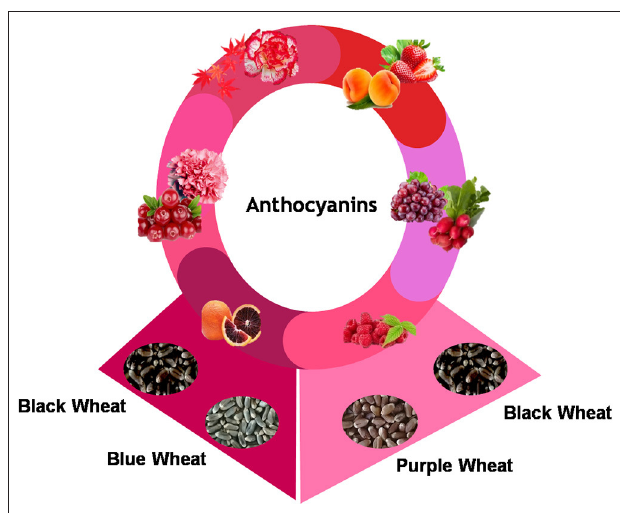
FIGURE 3 | Six types of anthocyanins are commonly found in colored wheat. Purple wheat has a higher content of cyanidin derivatives, while blue has delphinidin, and black has both of